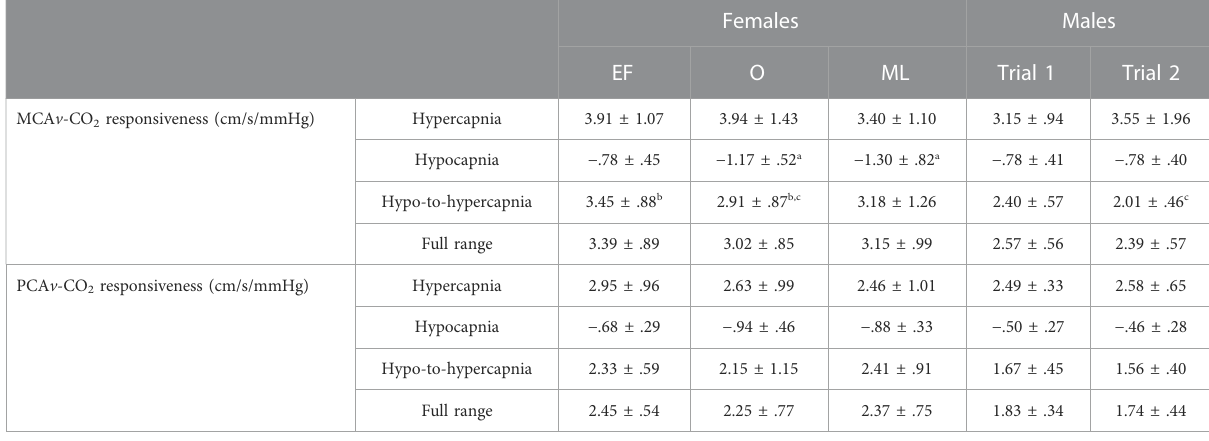
TABLE 3 Cerebrovascular-CO 2 responsiveness values for the middle cerebral artery (MCA v -CO 2 responsiveness) and posterior cerebral artery (PCA v -CO 2 responsiveness) in females during three phases of their menstrual cycle, and males during two repeat visits (A, B). Males are compared to females during the early follicular (EF) and ovulatory (O) phases only. “ Full range ” refers to the linear regression line of best- fi t which includes the Hypo1, Hyper1 and Hyper2 stages of the cerebrovascular responsiveness